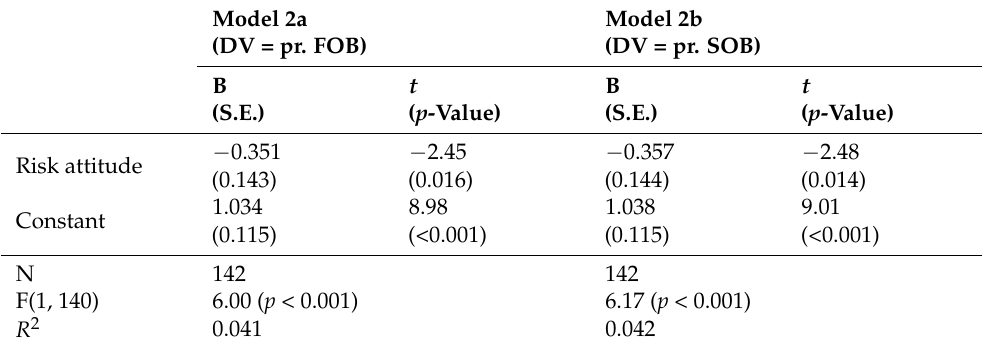
Table 5. Results of the linear regression analyses predicting probabilistic FOB and